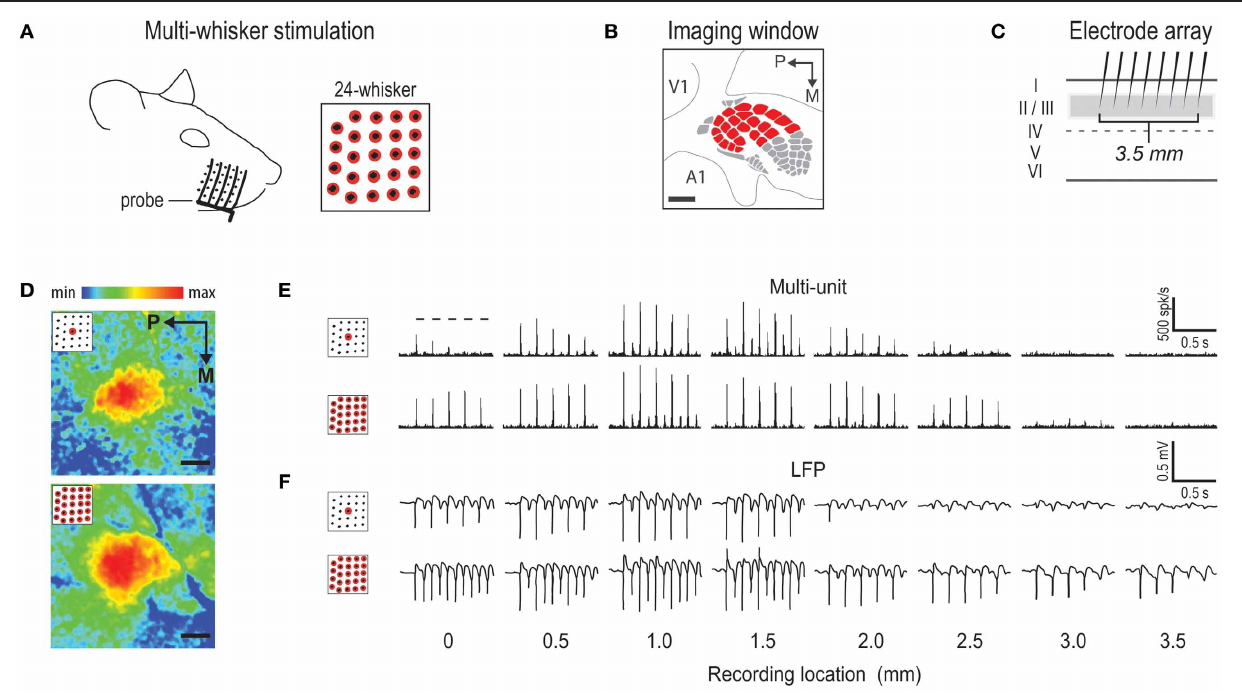
24-whiskers (bottom). Color scale indicates fractional change in poststimulus activity relative to prestimulus activity. (E,F) Representative cases of supra- (E) and sub- (F) threshold neuronal activity for C2 whisker ( E,F , top) and 24-whiskers ( E,F , bottom). The 5 dashes indicating stimulus delivery in top panel of ( E ) apply to all supra- and sub-threshold neuronal activity panels. All provided scale bars = 1mm. Both imaging and neuronal data are aligned according to location of peak activity for whisker C2. Note the similarity in location of peak activity and response magnitude between C2 whisker and 24-whiskers